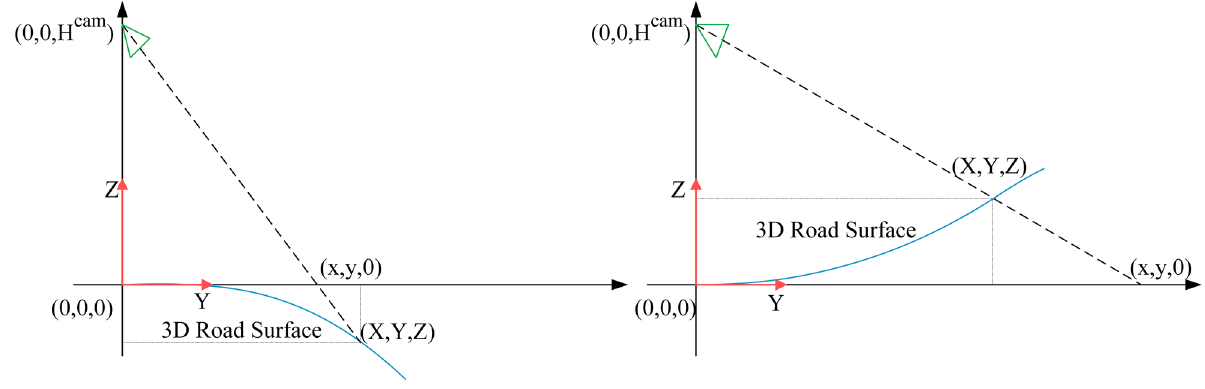
Figure 4. Geometric